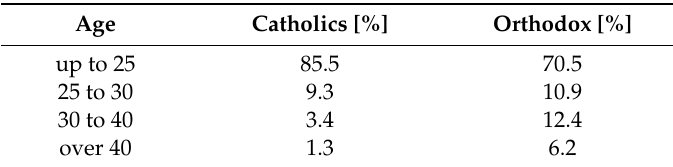
Table 1. Structure of respondents by age.